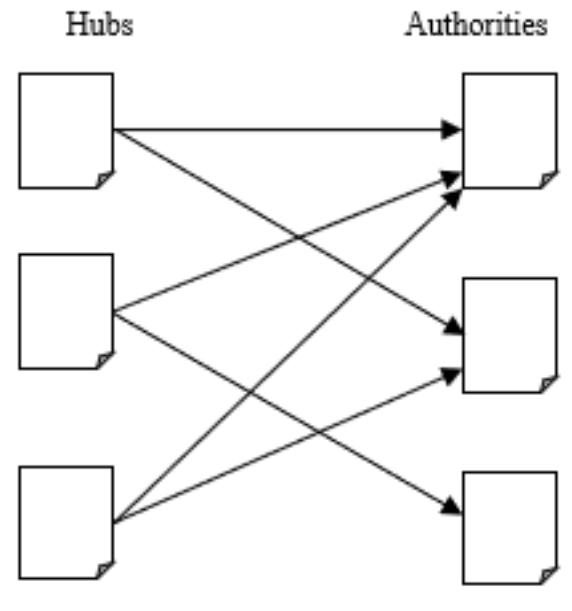
Figure 3: Illustration of Hub and